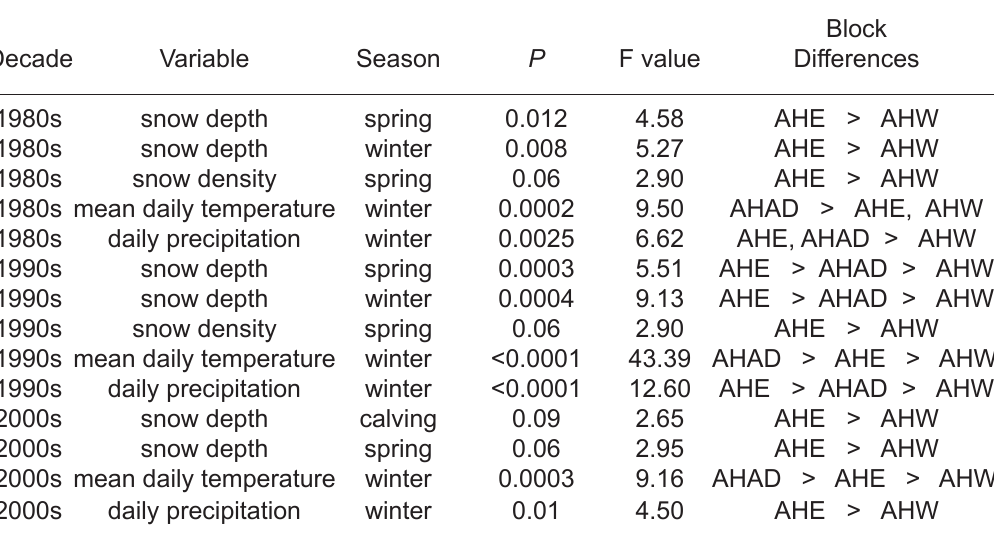
Table 3. Significant differences for decadal snow depth, daily precipitation and daily temperature (ANOVA and Duncan’s-Waller multiple range tests) among blocks based on MERRA climate